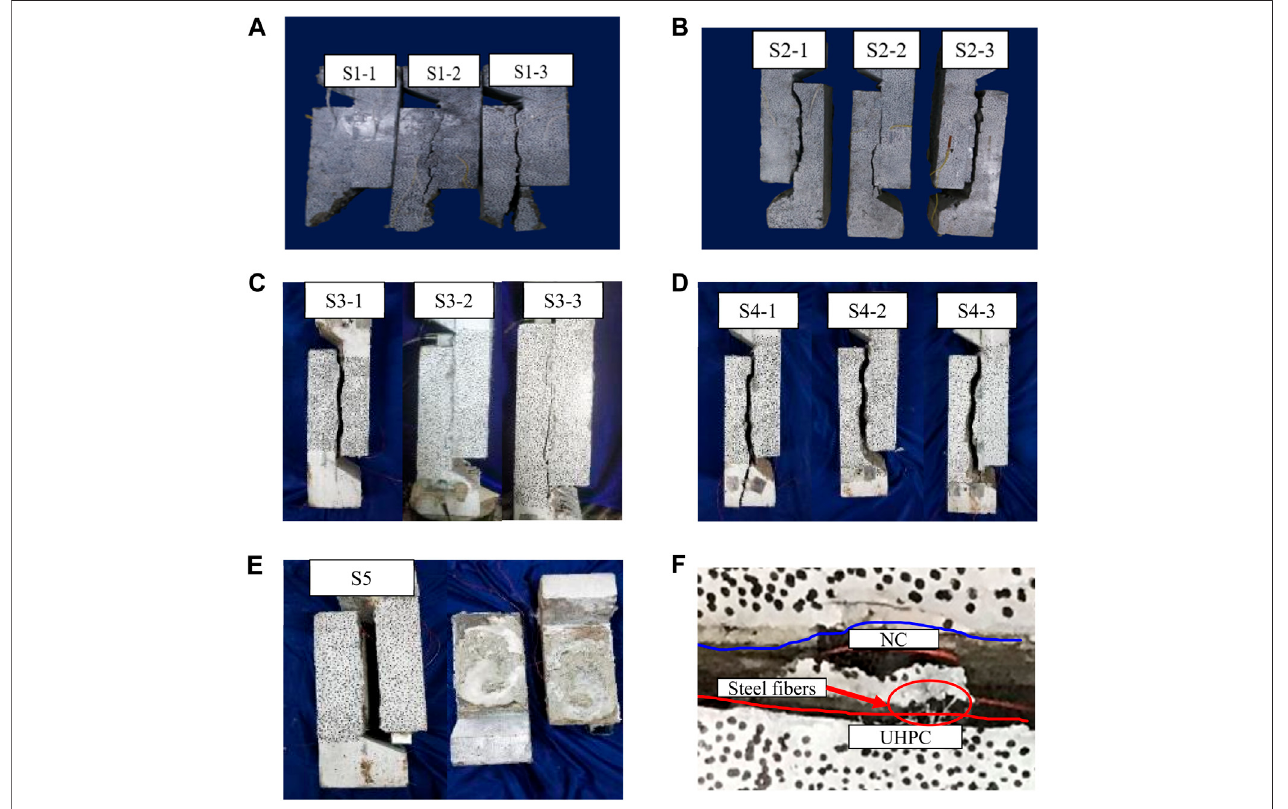
FIGURE 6 | Failure modes of interface. (A) S1. (B) S2. (C) S3. (D) S4. (E) S5. (F) Steel fi bers and cracks at the